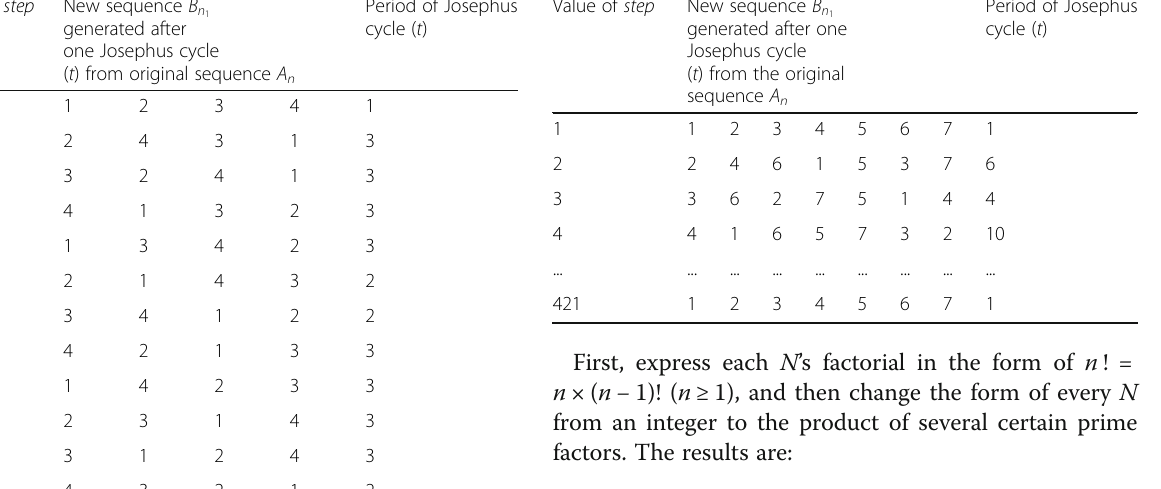
Table 3 Josephus cycle state of each step value in experiment 3 Value of step New sequence B n Period of Josephus 1 generated after cycle ( t ) one Josephus cycle ( t ) from original sequence A n